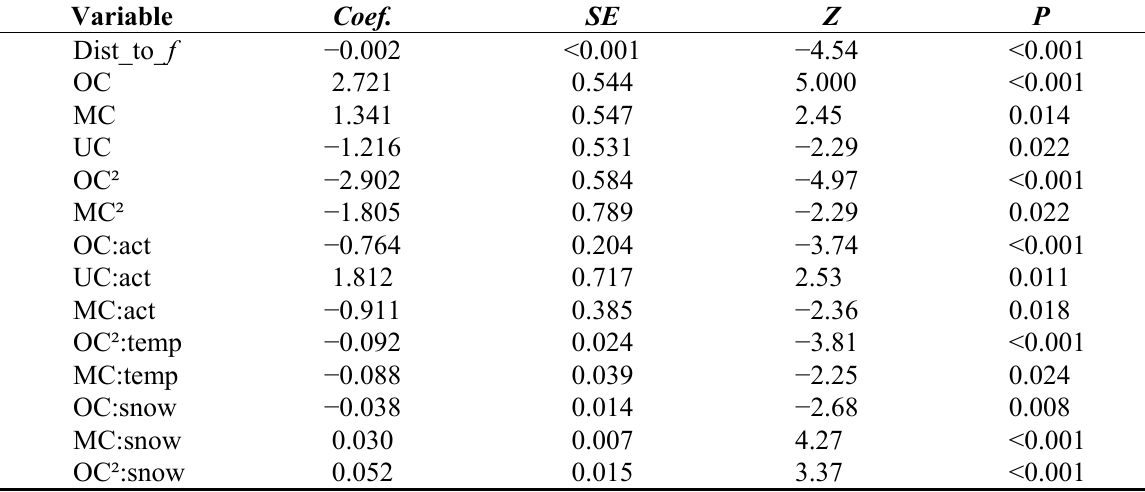
Table 2. Results of mixed conditional logistic regression with individuals as random effect distance to nearest artificial feeding place, OC: overstory cover, MC: midstory cover,